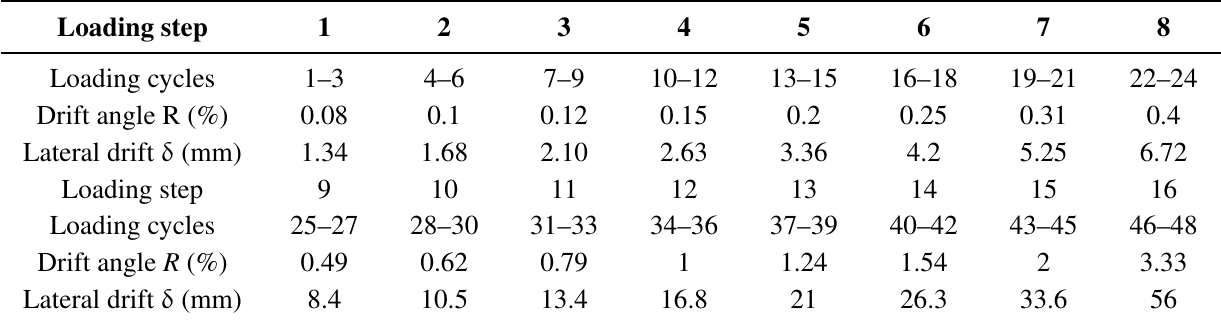
Table 4. The loading cycles used in the experiments.